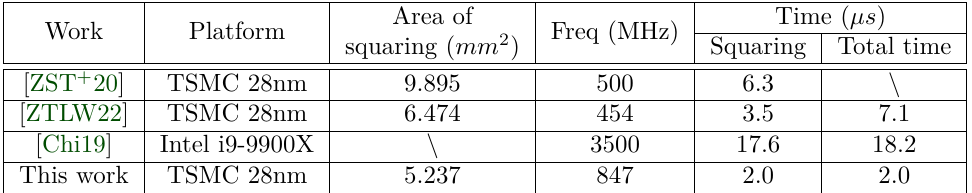
Table 7: Comparison to implementations of the reduced squaring in the class group.